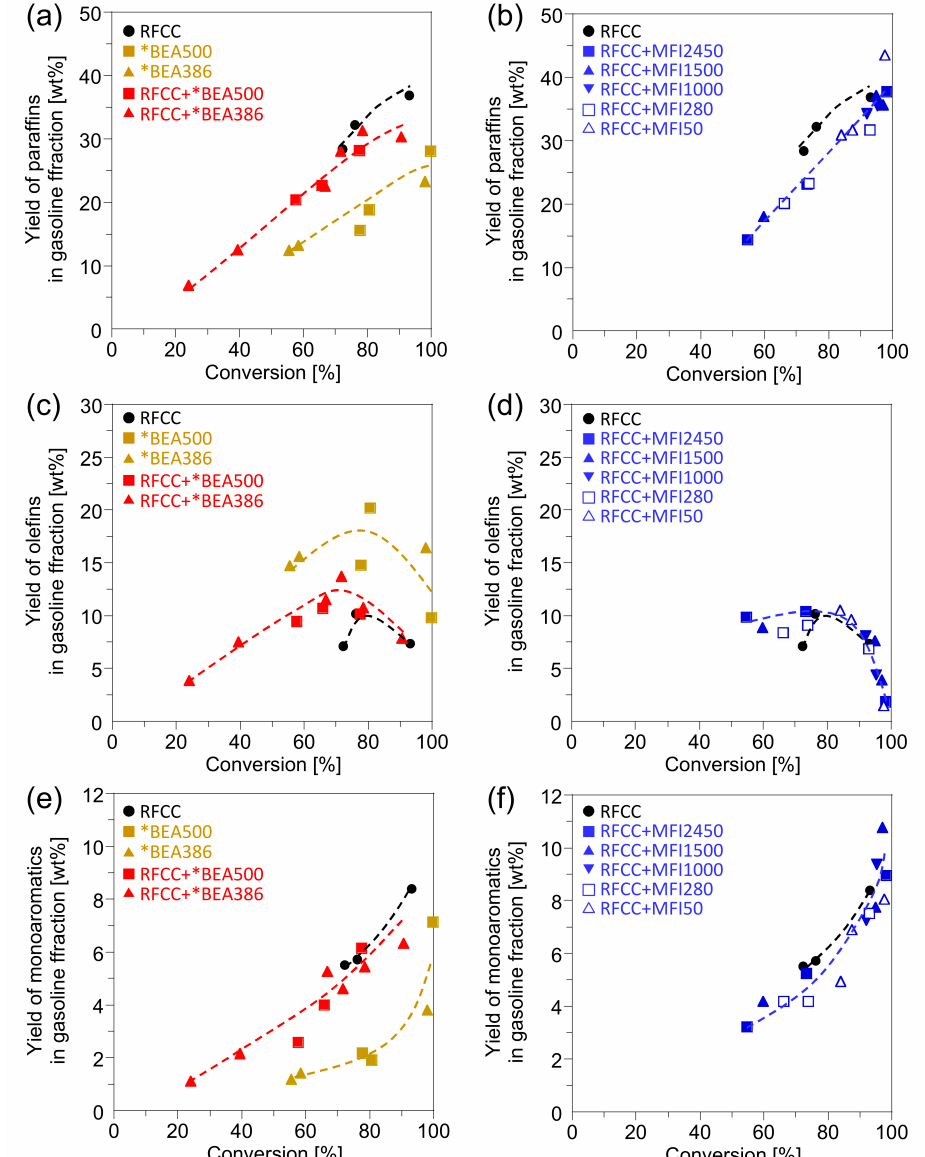
Figure 3. Yields of the products in the gasoline fractions. ( a )( b ) Paraffin yield. ( c )( d ) Olefins yield. ( e )( f )Monoaromatics yield. ( a )( c )( e ) Reaction product on the *BEA catalyst and the composite catalyst with the *BEA zeolite. ( b )( d )( f ) Reaction product on the composite catalyst with the MFI